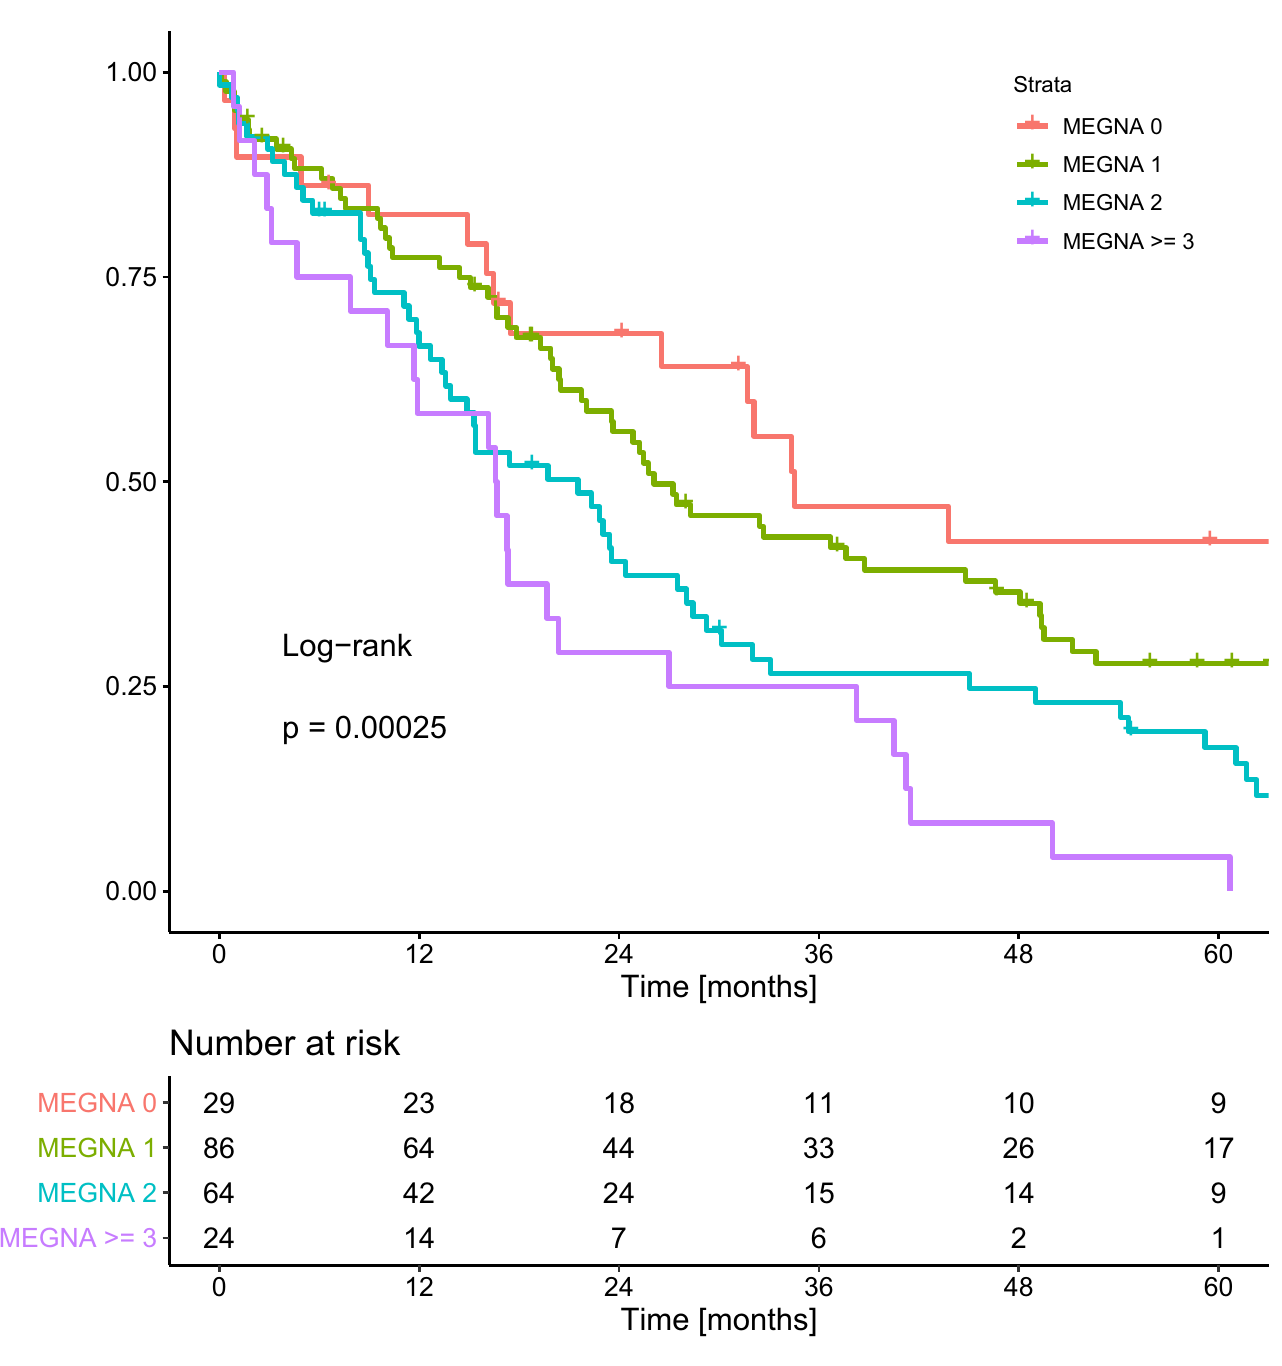
Fig 2. Kaplan Meier curves of overall survival stratified according to